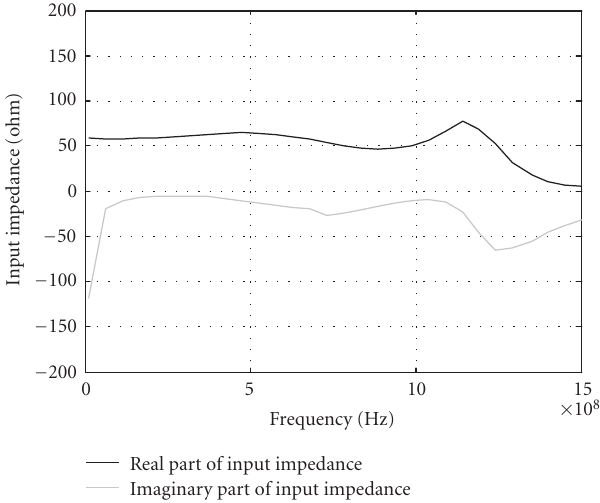
Figure 8: Simulated input impedance HMS UWB antenna with rectangular slot.